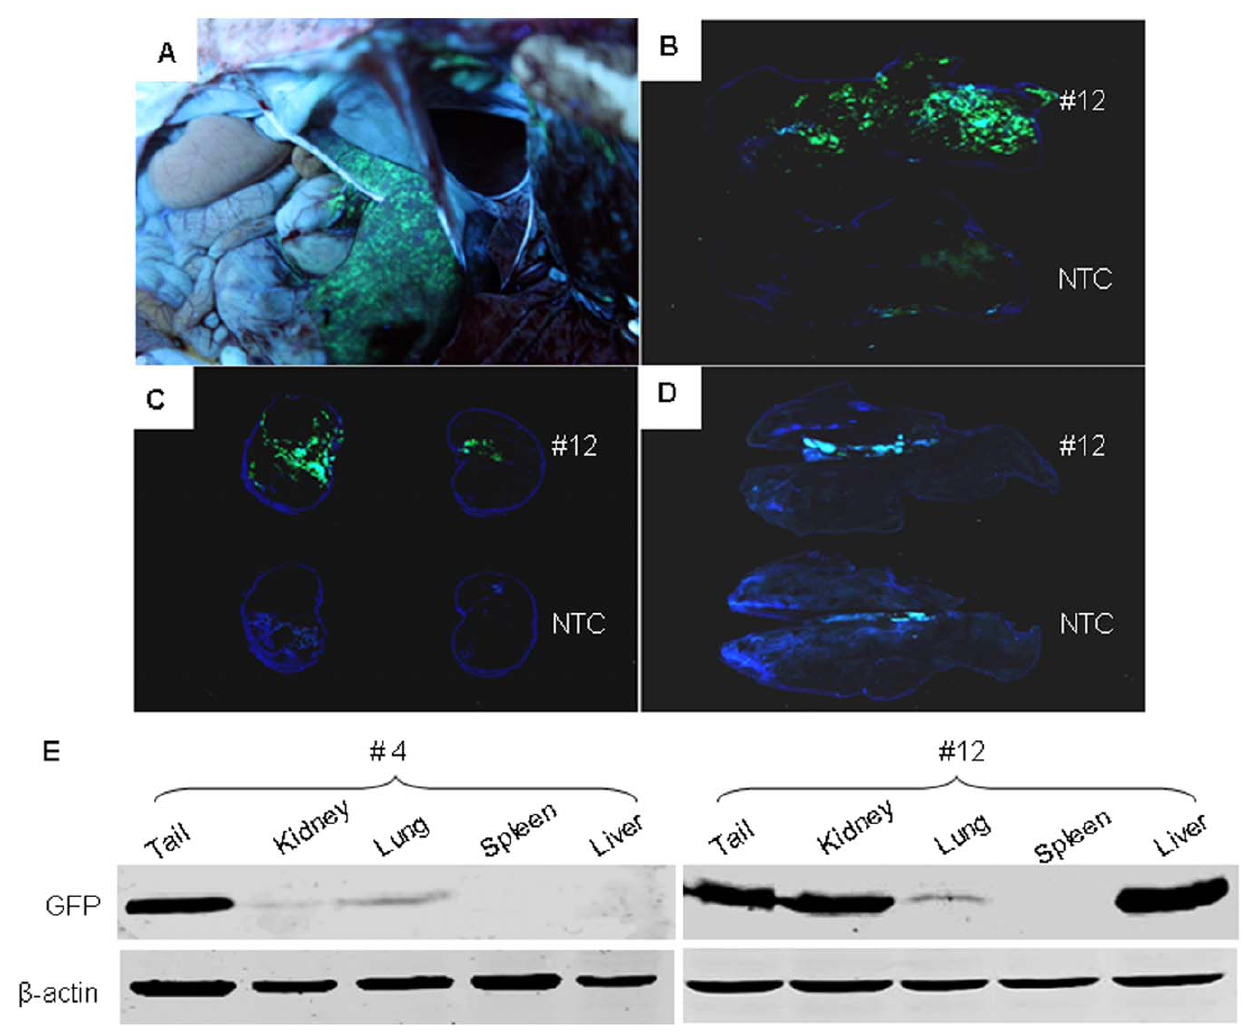
Figure 4. Expression of GFP in tissues of transgenic lambs observed by fluorescence imaging and assayed by western blotting. (A) Fluorescence imaging of the whole inner organs of transgenic sheep under white light. (B-D) Fluorescence imaging of liver, kidney and lung of transgenic or NTC sheep. The upper are organs of the transgenic sheep and the lower are organs of the NTC sheep. (E) Expression of GFP in tissues assayed by western bloting. Proteins extracted from tissues of tail tip, kidney, lung, spleen and liver of # 4 and # 12 lambs were subjected to immunoblotting with GFP antibody as described in Materials and Methods. b -actin levels were determined with an anti- b -actin antibody as loading